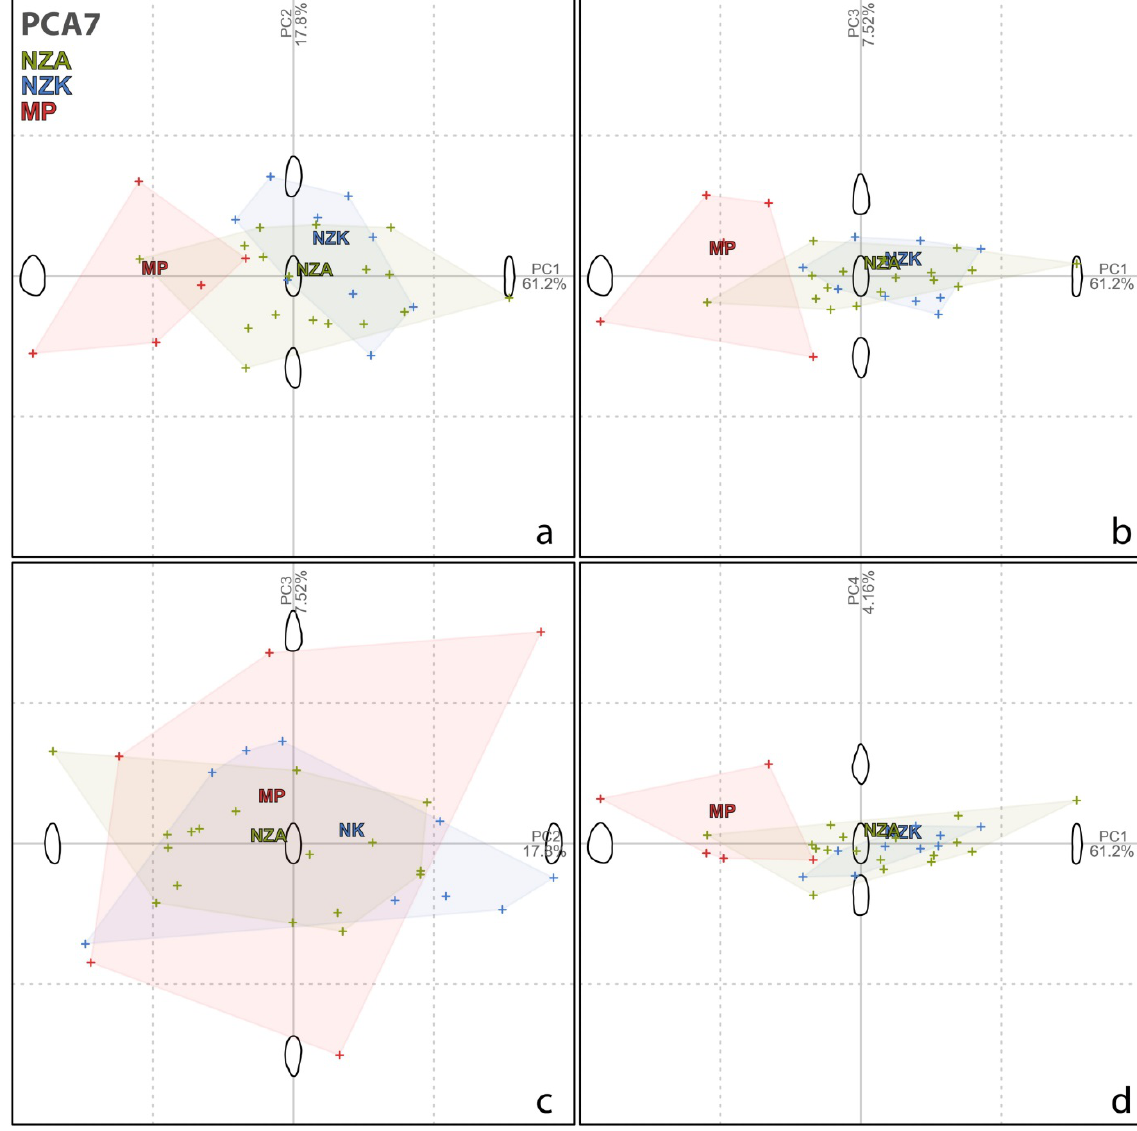
Figure 18. PCA7 - Plot of the PCA scores on the first four PCs. PCA is realised on the EFA coefficients. This PCA concerns Lupemban points only. Colors represent sites (green: NZA, blue: NZK, red: